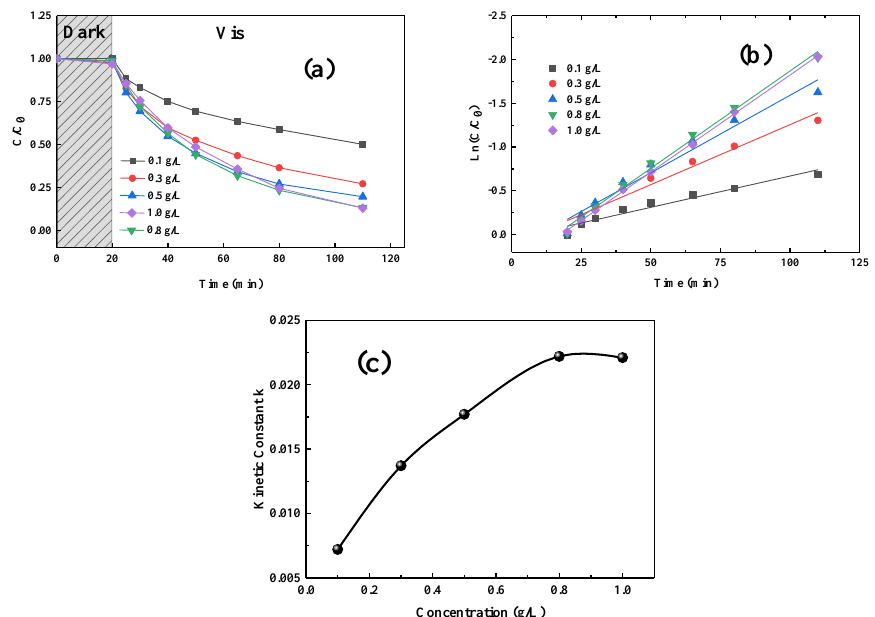
Figure 5. E ff ect of the concentration of 1% rGO–P25 on BPA degradation under visible light irradiation. ( a ) Curve of C / C 0 versus time; ( b ) corresponding ln(C / C 0 ) and time curve; ( c ) first-order kinetic constant curve of k versus catalyst concentration (BPA concentration = 0.01 mol / L, volume of the solution = 100 mL, λ = 420 nm, 10 tubes).